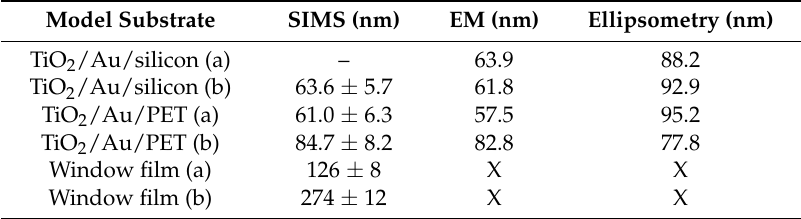
Table 4. Results overview of secondary ion mass spectrometry (SIMS), electronic microscopy (EM), and ellipsometry measurements. For each model type, two individual samples (a and b) were synthesized and characterized. A graphical representation is shown in Figure